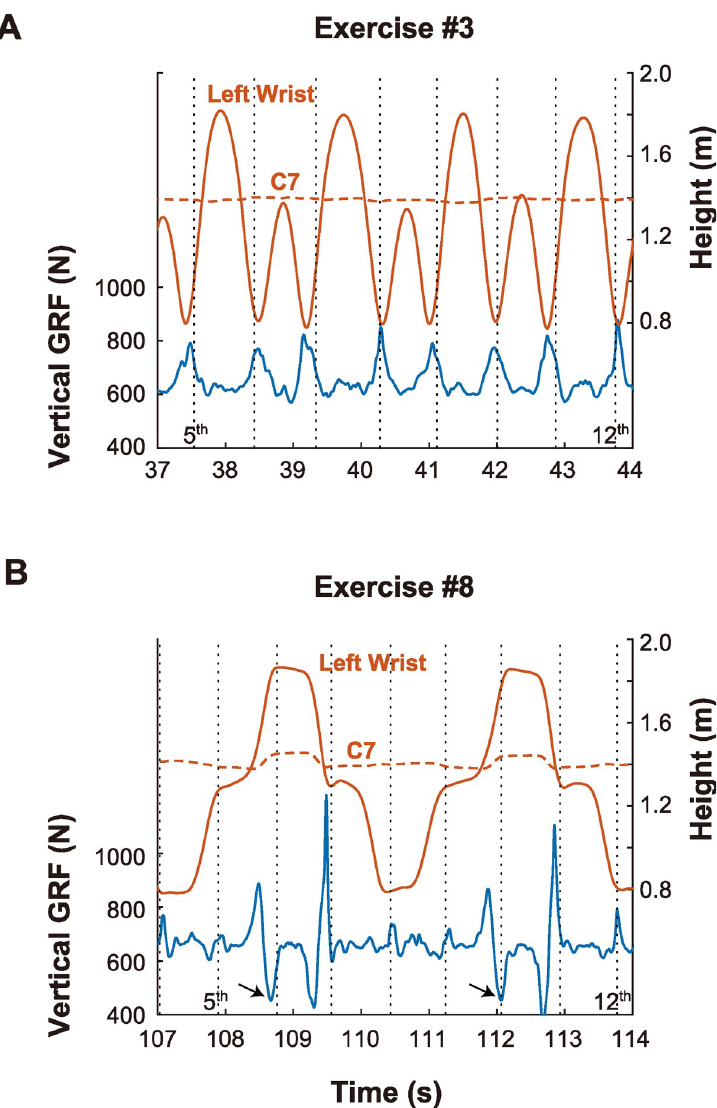
Fig 7. Temporal relationship between vGRF and body motion. This figure shows two examples of temporal changes in the vertical ground reaction force (vGRF) and in the heights of the left wrist (solid line) and spine at C7 (broken line). Panels A and B shows the data from Exercise #3 and #8, respectively. Vertical broken lines indicate the timing of music beats (from 5 th to 12 th ). Generally, temporal locations of the vGRF peaks coincided with the music beats. Small arrows indicate the cases in which the negative vGRF peaks coincided with beats. These vGRF peaks has good agreement with the timings of the lowest positions (Exercise #3) and endpoints (Exercise #8) of wrist movement.